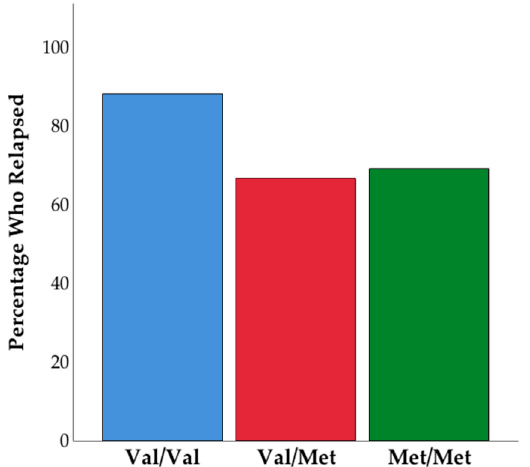
Figure 2. Mean Obsessive Compulsive Drinking Scale scores by catechol- O -methyltransferse ( COMT ) genotype. * p < 0.05.